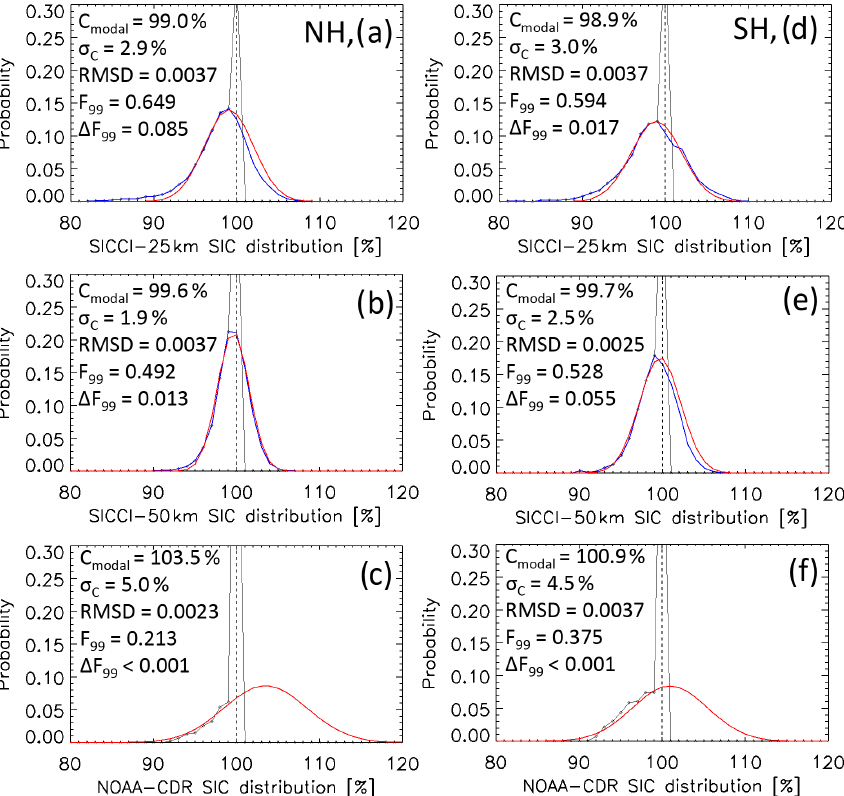
Figure 3. Examples of the sea-ice concentration distribution at near-100% reference sea-ice concentration locations. Black symbols and lines show values cut off at 100%; blue lines denote the original distribution (for SICCI-25km and SICCI-50km only); red lines denote the distribution resulting from the Gaussian fit to values of the distribution ≤ 99%. In each panel, the modal sea-ice concentration (centre of the Gaussian fit: C modal ), the standard deviation of the fit σ C and fit parameters with respect to the fraction of the distribution ≤ 99% ( F 99 , (cid:49)F 99 ; see text for more explanation), and the root-mean-squared difference (RMSD) between original and fitted probability are